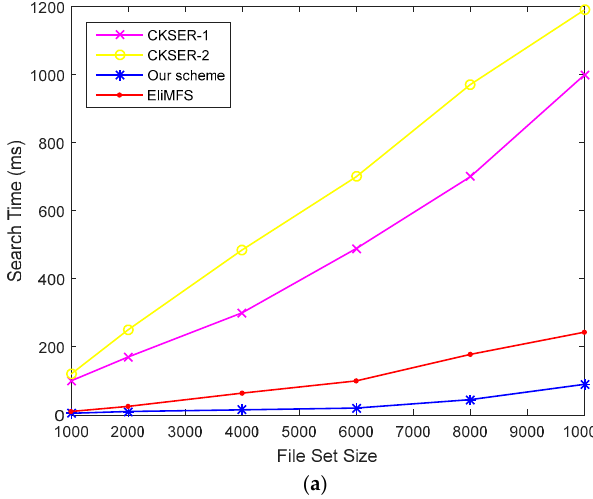
Sensors 2018 , 18 , x FOR PEER REVIEW Figure 10. Precision of auto correction. Figure 10. Precision of auto correction.